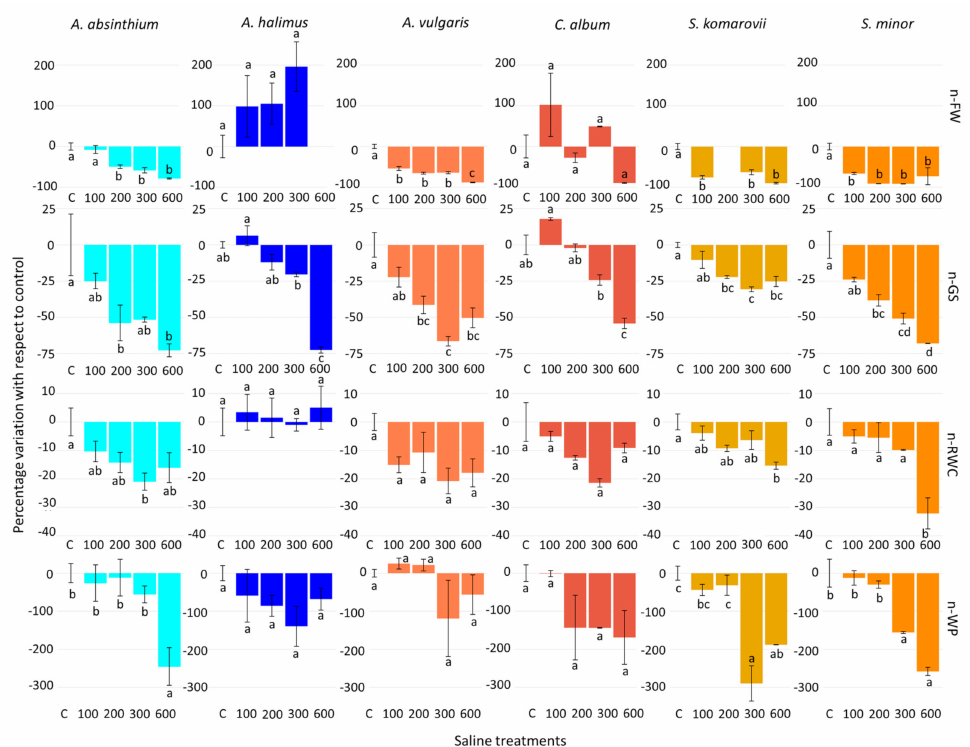
Figure 2. Control-normalized percent differences in fresh weight (n-FW), stomatal conductance (n-GS), leaf relative water content (n-RWC), and leaf water potential (n-WP) within species due to the different saline treatments experimented in the study. Different letters indicate significant differences at p ≤ 0.05. Vertical bars indicate ± one standard error. In A. halimus and S. komarovii , one n-FW level is missing due to dead plants at